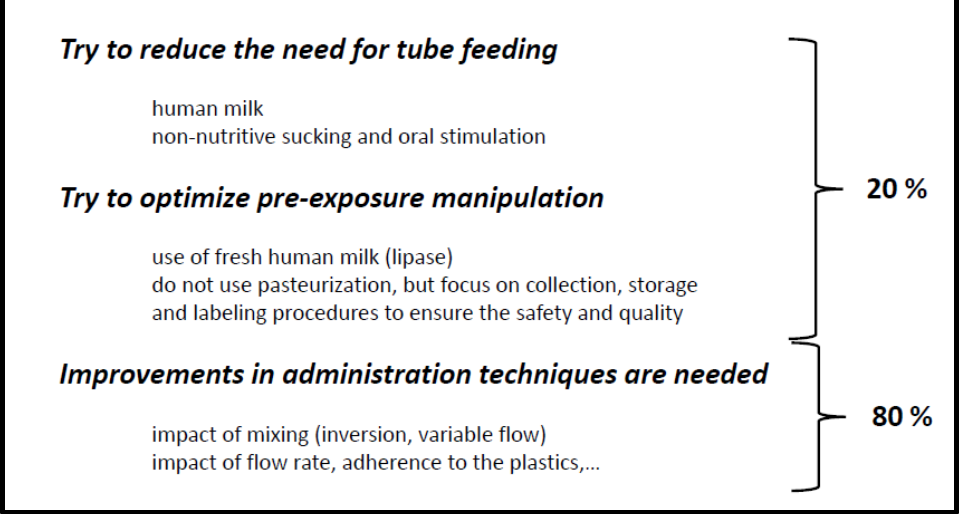
Figure 2. Strategies to reduce pre-exposure fat losses during nasogastric tube feeding. Relevant efforts have been made to improve the relative limited (20%) losses on tube feeding and pre-exposure manipulation, while there is still much to gain through improvements (80% of relative fat losses) in administration techniques.